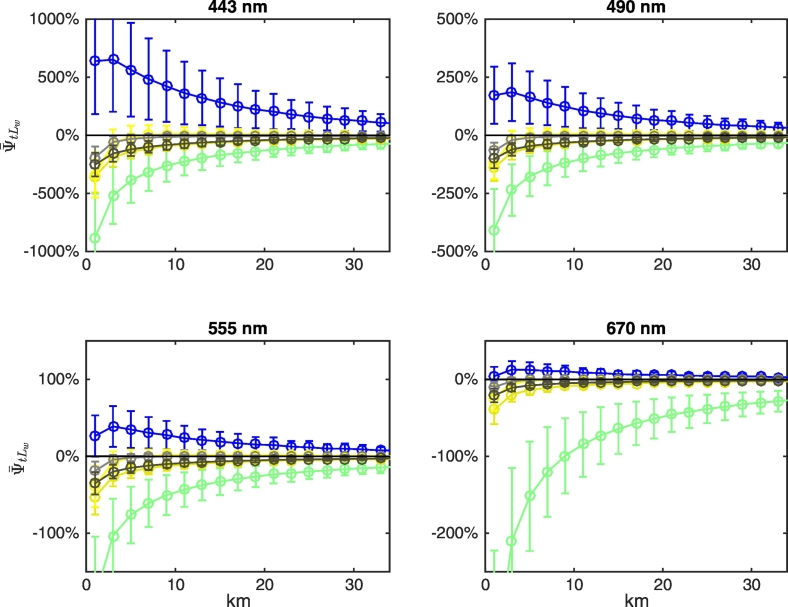
As in Fig. 14 but for BLTS waters.